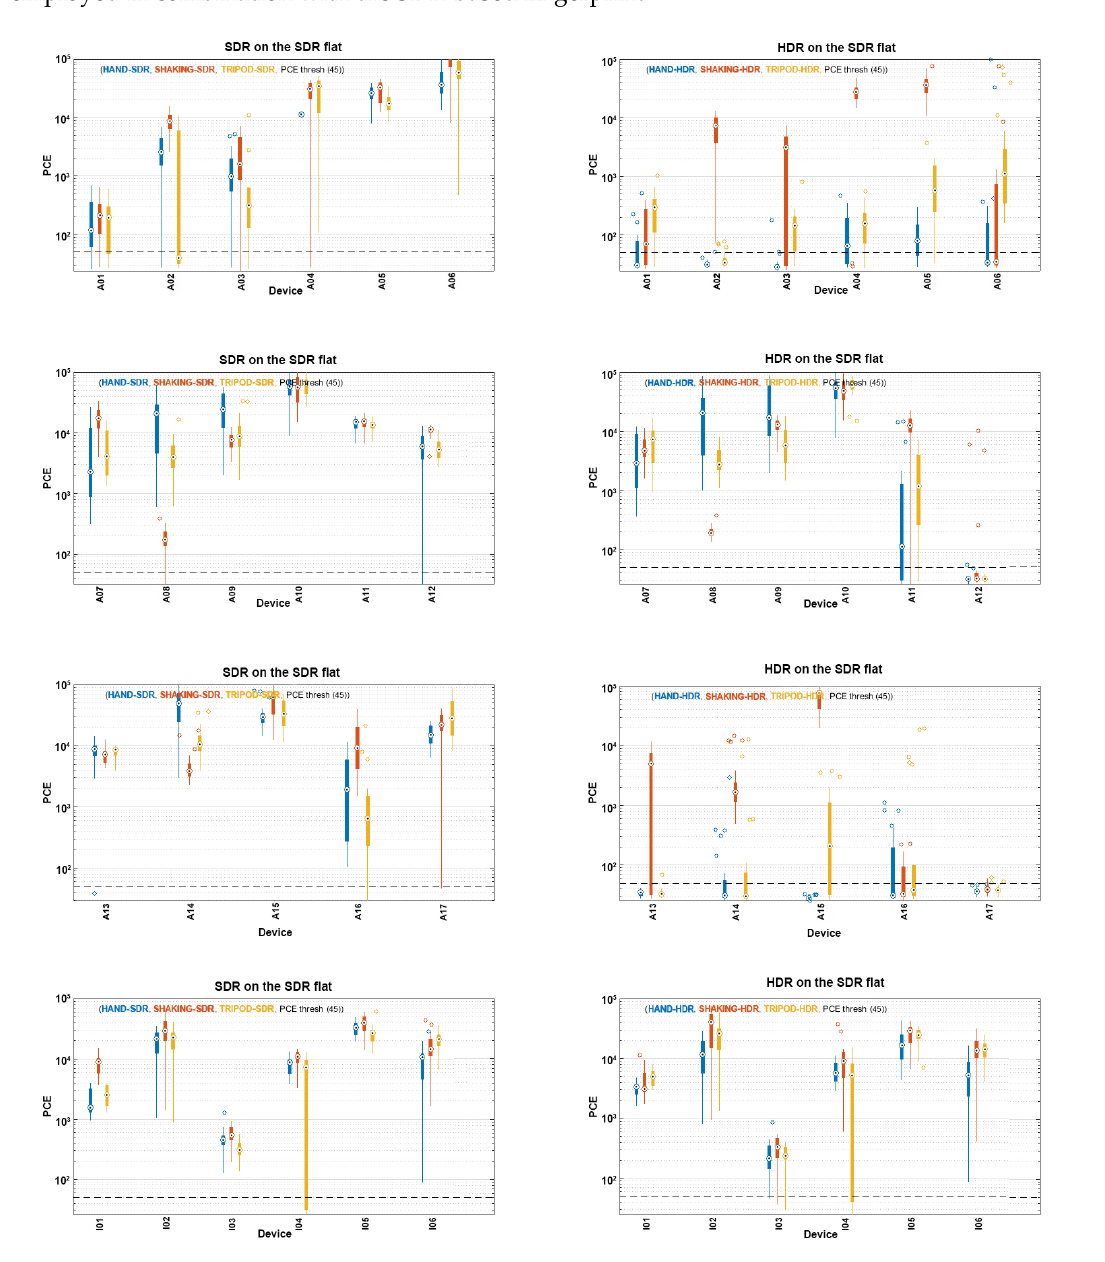
Figure 5. PCE values obtained for SDR and HDR images when compared with a flat SDR-based